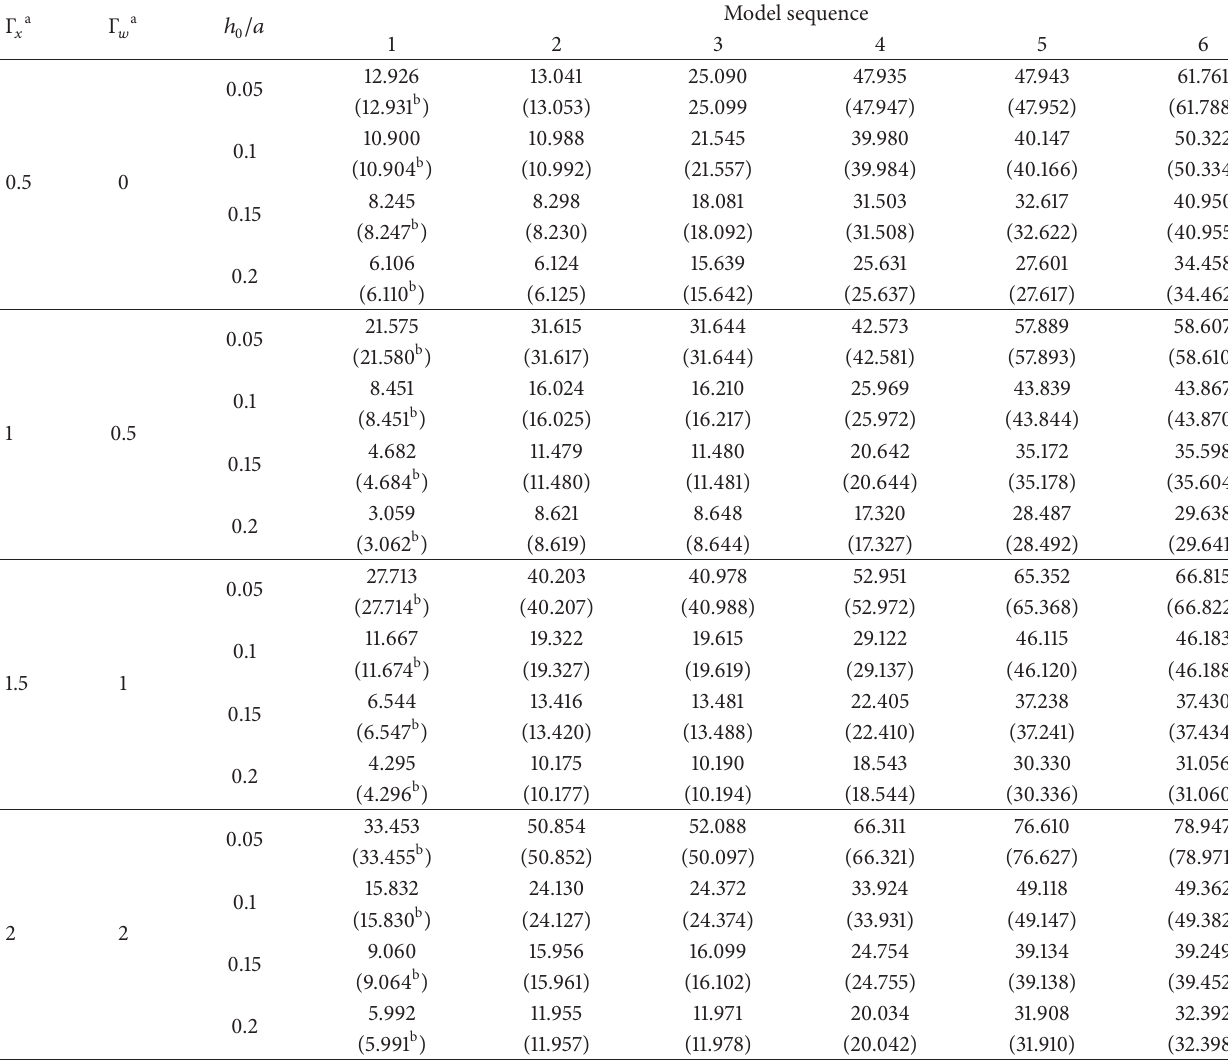
Table 11: Frequency parameter Ω = 𝜔𝑎 2 (𝜌ℎ 0 /𝐷 0 ) 1/2 for moderately thick plates ( 𝑎/𝑏 = 1 ) with linearly varying thickness and elastic rotation and translation support ( ℎ(𝑥,𝑦) = ℎ 0 (1 + 0.5𝑥 2 )(1 + 0.5𝑦 2 ) , 𝐾 𝑥0 = 𝐾 𝑥𝑎 = 𝐾 𝑦0 = 𝐾 𝑦𝑏 = Γ 𝑥 , and 𝑘 𝑥0 = 𝑘 𝑥𝑎 = 𝑘 𝑦0 = 𝑘 𝑦𝑏 = Γ 𝑤